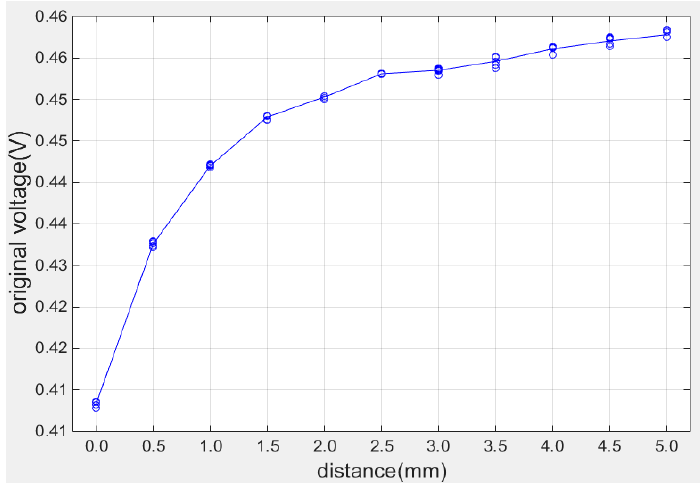
Figure 8. Repeatability measurement at different position. Table 2. Repeatability measurement data.